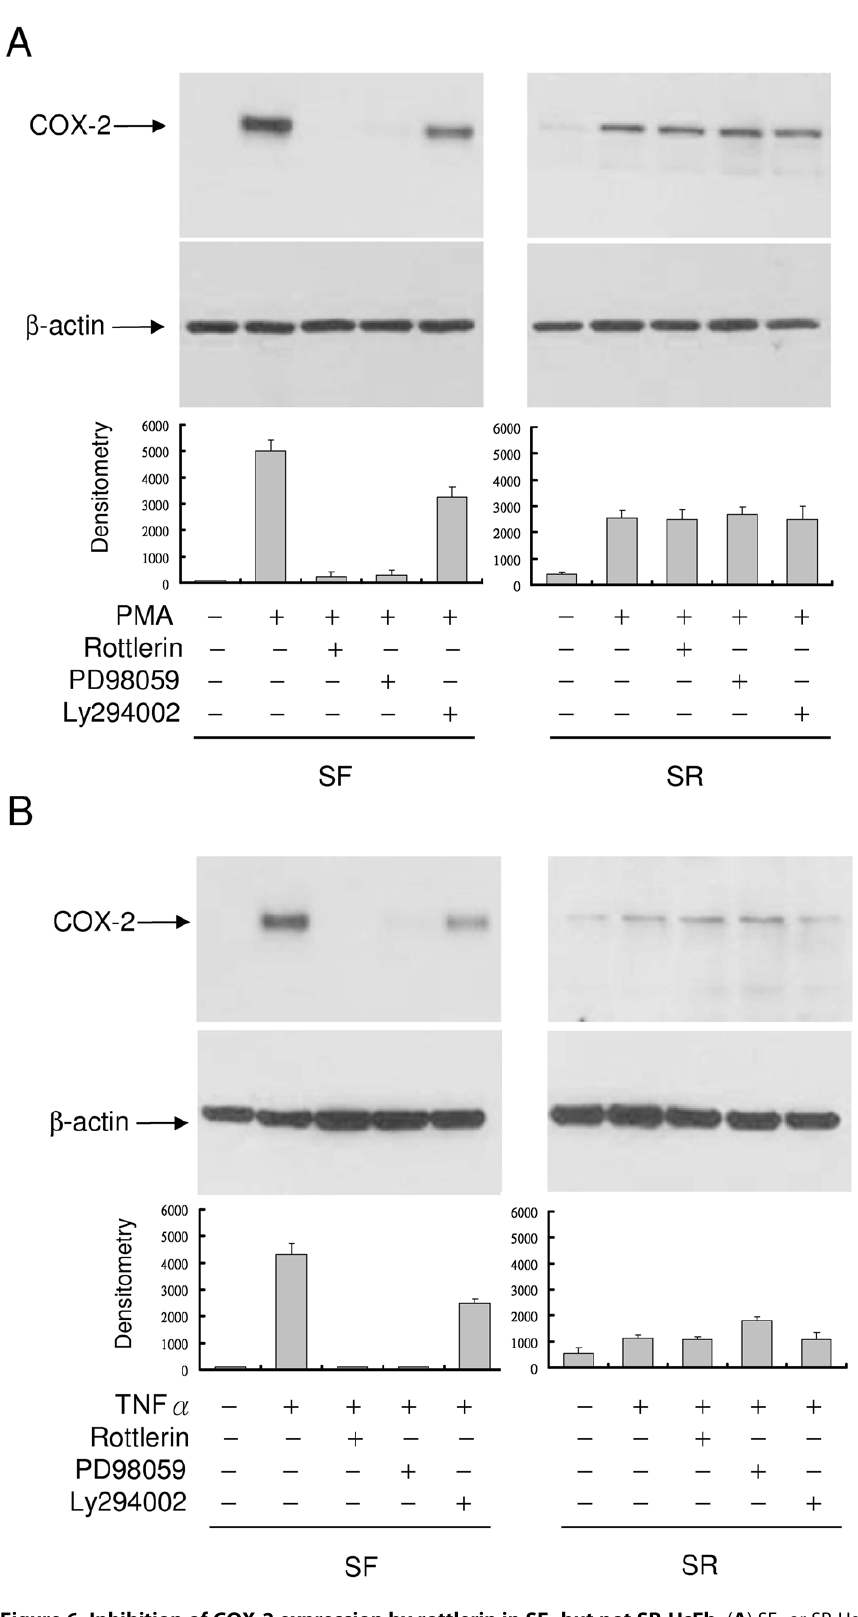
Figure 6. Inhibition of COX-2 expression by rottlerin in SF- but not SR-HsFb. ( A ) SF- or SR-HsFb were pretreated with rottlerin, PD98059 or Ly294002 followed by treatment with PMA for 4 h. COX-2 proteins were analyzed by Western blotting. ( B ) SF- and SR-HsFb were treated with the pharmacological inhibitors followed by TNF a . Upper panels show representative Western blots and the lower panel, densitometry analysis (mean 6 SEM, n=3). doi:10.1371/journal.pone.0049232.g006 PLOS ONE |